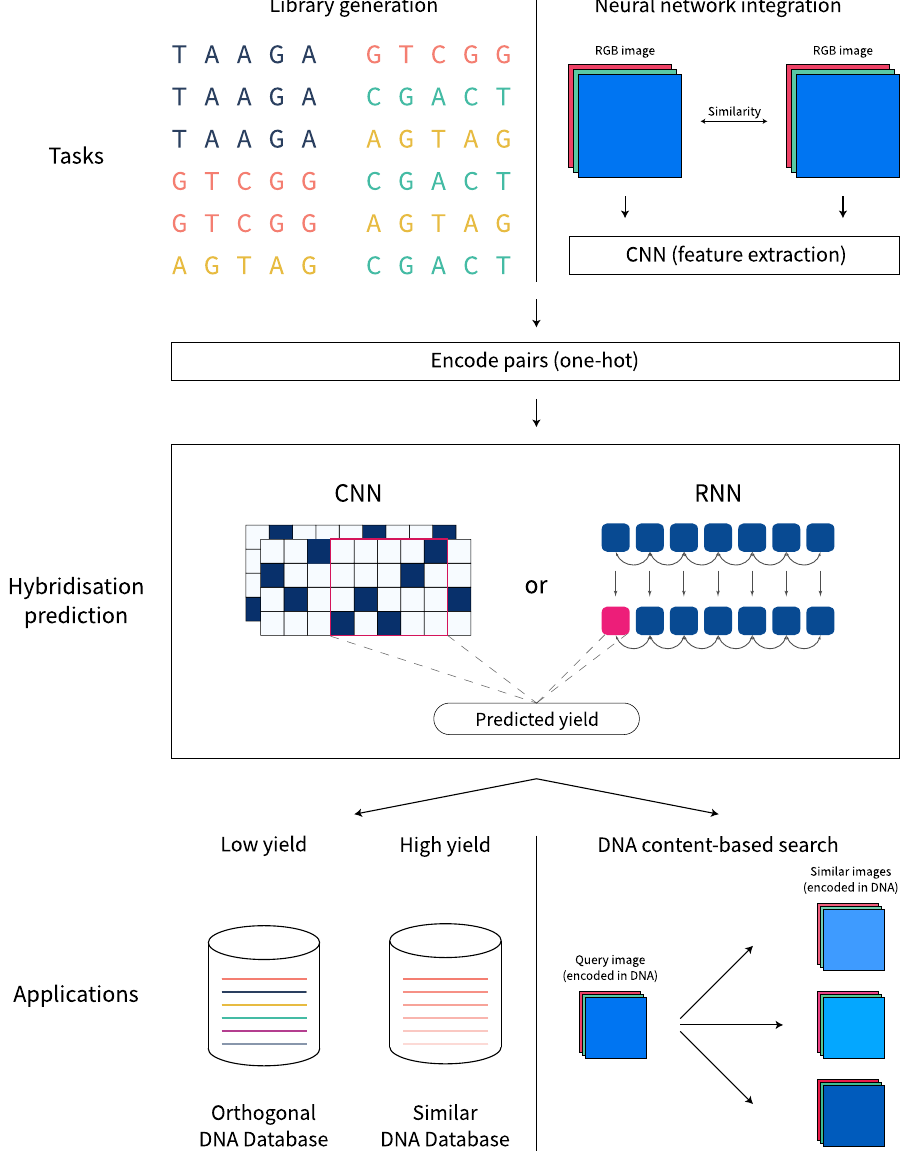
Figure 1. A high-level overview on how to integrate hybridisation prediction into DNA storage workflows. A trained machine learning model can be used as a standalone tool to assemble orthogonal or similar libraries of DNA sequences (left half of the figure). Alternatively, the neural network can be seamlessly integrated into a larger machine learning model as a subcomponent. The presented example is content-based search in a DNA database, where document features are extracted by a neural network (CNN for images, but text, video or audio inputs are conceivable) in a pairwise manner, another neural component generates appropriate encodings (usually one-hot) and the hybridisation predictor outputs the expected yield of the pair. Such a model is trained to associate similar documents to similar single stranded DNA sequences that form stable duplexes with the query sequence (right half of the